Question: What direction does the quantity move in — increasing or decreasing?
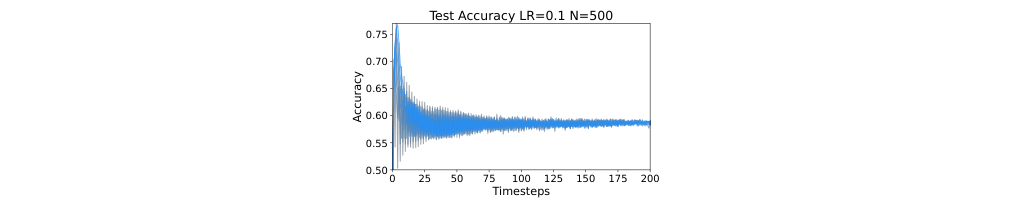
Answer: increasing